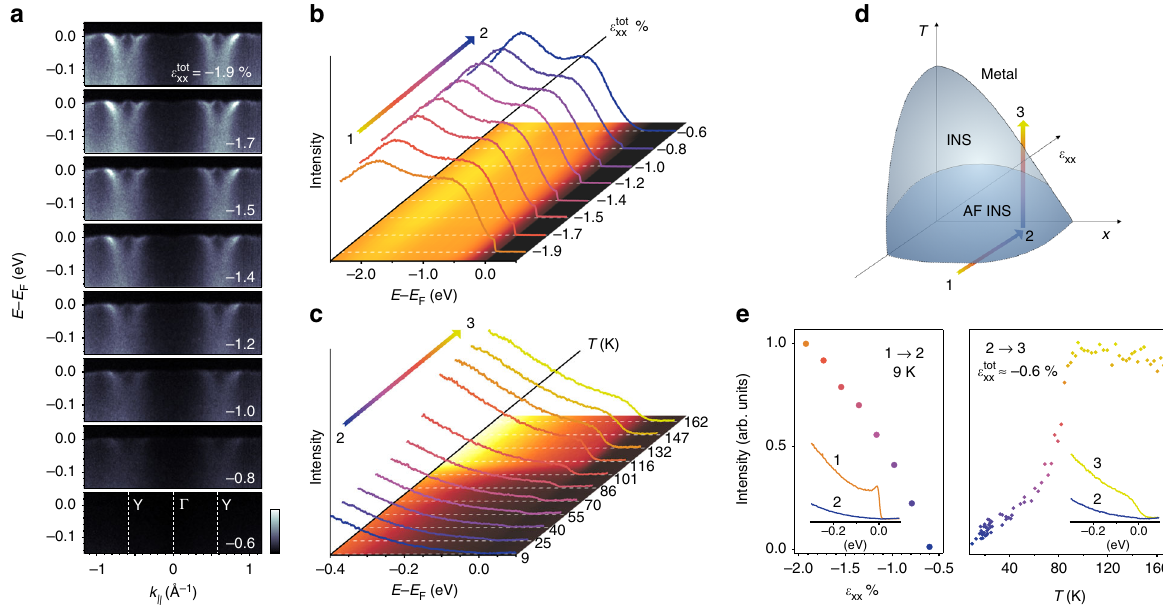
Fig. 3 Strain tuning of the MIT. a Evolution of the quasiparticle band structure of Ca 2 − x Pr x RuO 4 for x = 0.07 along Y Γ Y at 8 K as the strain is tuned along the path 1 → 2 in the schematic phase diagram shown in d . The data were acquired using 64 eV photons with linear horizontal polarization. Light colors correspond to high intensities. b Angle-integrated energy distribution curves (EDCs) over the full width of the occupied Ru t 2 g states as a function of (cid:3) (cid:2) 0 : 6 % (path 2 → 3). The sample undergoes uniaxial strain. c Angle-integrated EDCs as a function of temperature measured at minimum strain ε tot xx the MIT at ~90 K. e Evolution of the spectral weight at the Fermi level along the path 1 → 2 → 3 de fi ned in